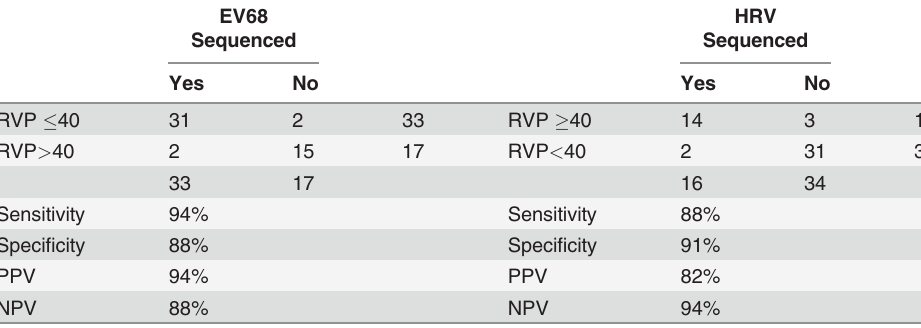
Table 4. Differentiating EV-D68 from HRV by RVP signal of